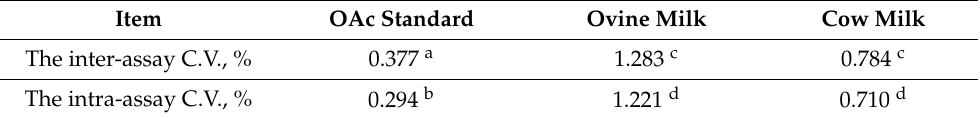
Table 4. The inter- and intra-assay coefficient of variations (C.V., %) from the measurements of OAc concentrations in OAc standard solutions and milk of sheep and cows.